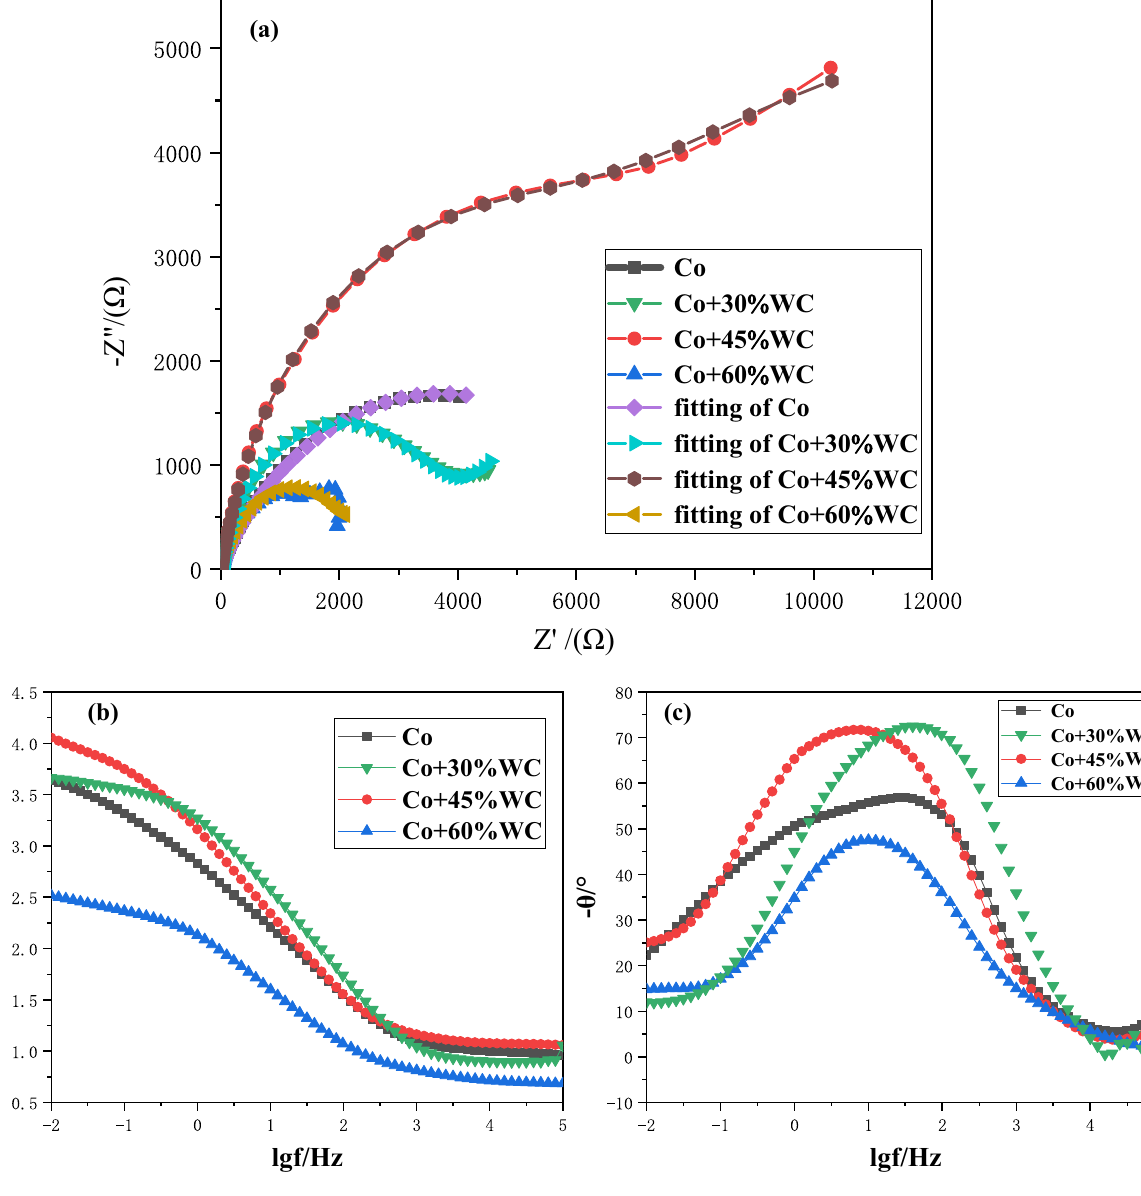
Figure 9: Impedance spectra of Co – WC coatings and Co coating in 3.5 wt% NaCl solution. ( a ) Nyquist plots; ( b ) Bode impedance plots and ( c ) Bode angle